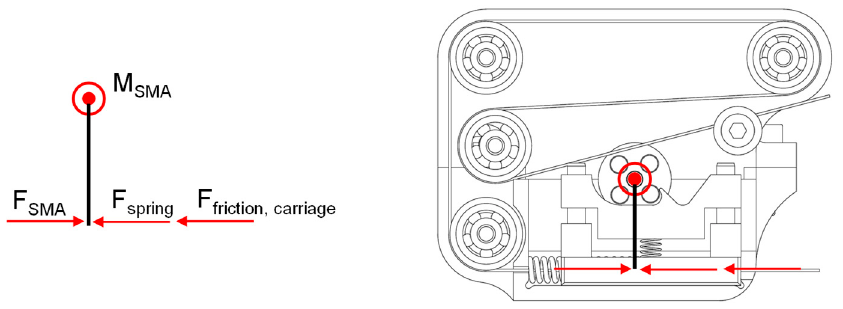
Figure 9. Conversion of the wire force into a moment.